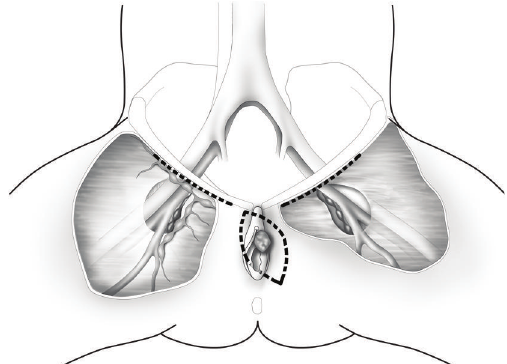
Figure 4: Radical wide excision and ipsilateral superficial inguinal lymphadenectomy is performed for lateral T 1 or T 2 vulvar cancers. All lymph nodes above the cribriform fascia are removed and the saphenous vein is preserved.